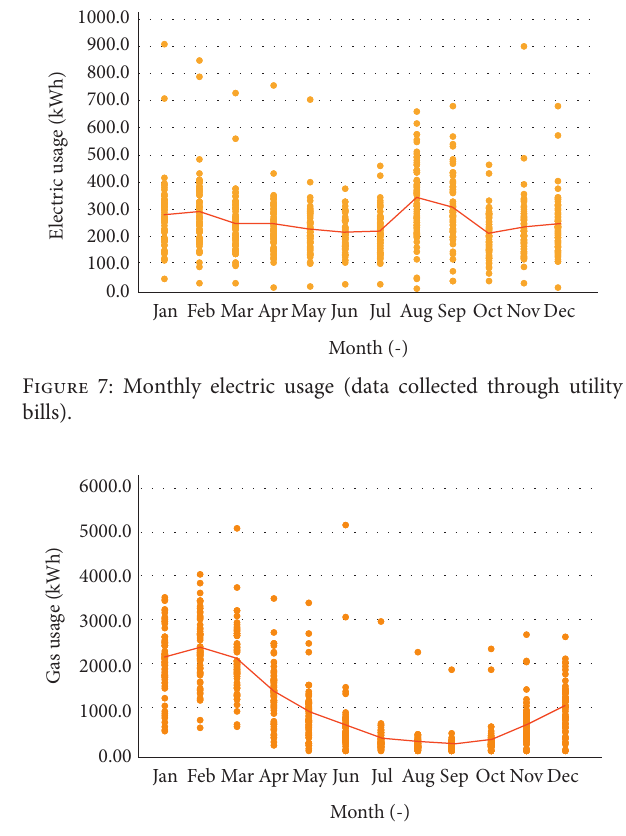
Figure 8: Monthly gas usage (data collected through utility